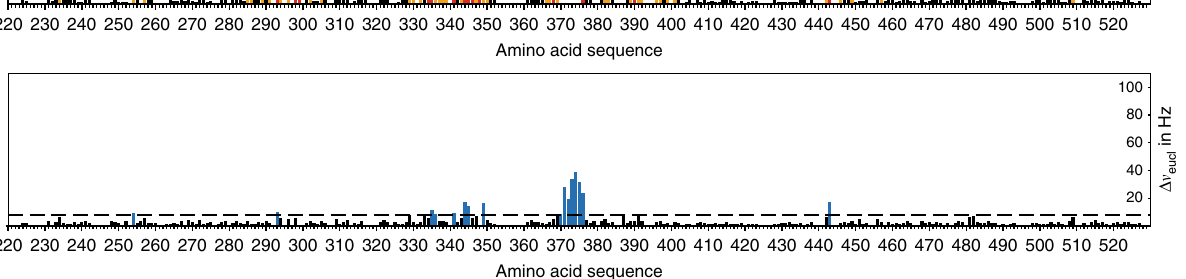
Fig. 5 Binding of blood group B trisaccharide to GII.4 Saga P-dimers. a 1 H, 15 N, TROSY HSQC spectra of native (red, left) and deamidated (blue, right) Saga P-dimers in their free forms and in the presence of 20 mM B trisaccharide (orange). Perturbations induced by ligand binding are indicated by arrows for selected amino acids. b Mapping of chemical shift perturbations (CSPs) for both forms onto the crystal structure of P-dimers complexed with B trisaccharide (pdb: 4X06). c Complete chemical shift mapping of the respective P-dimer species with experimentally determined 7.9 Hz signi fi cance thresholds and additional 2 σ threshold to indicate largest CSPs in native P-dimers. Source data are provided as a Source Data fi